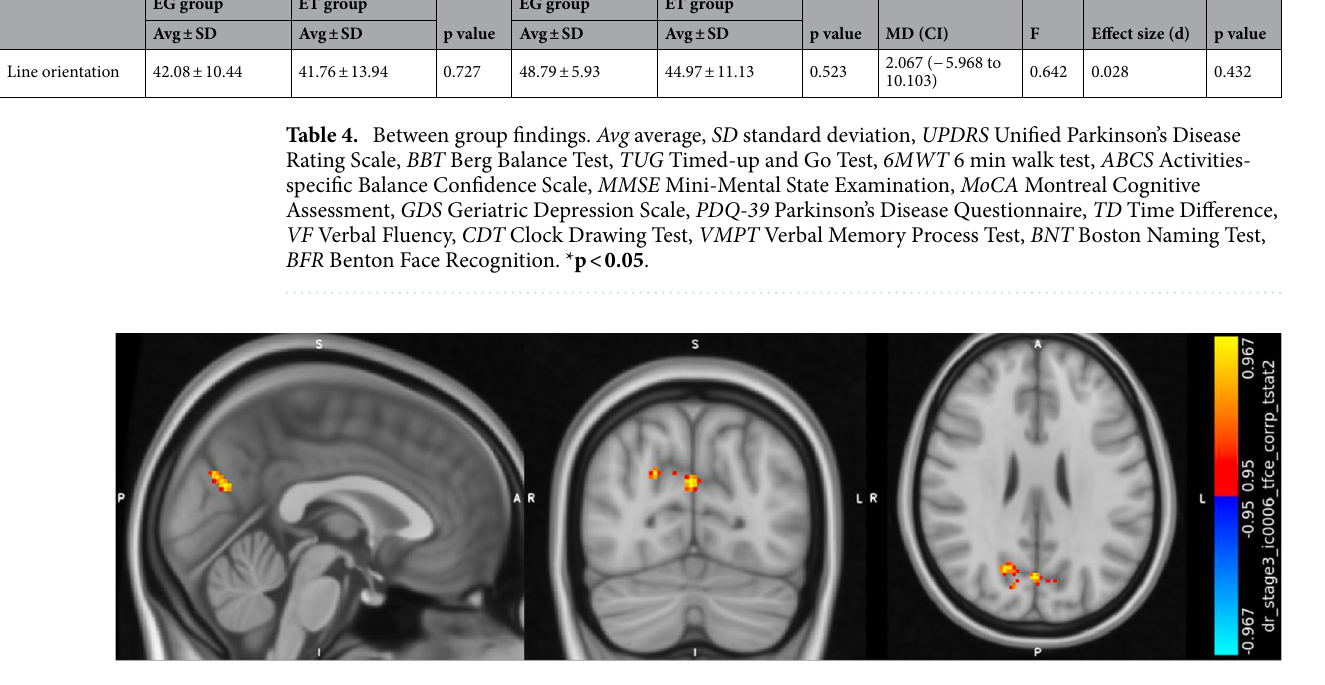
Figure 2. Results of rs-fMRI analysis in the between group comparison. Between groups comparisons, results of Dual Regression with group × time interaction, showing increased activation in the precuneus cortex (Harvard-Oxford Atlas), corrected for multiple comparisons with threshold-free cluster enhancement (tfce, p-value < 0.05). Peak MNI152 coordinate: [0 −72 25]; Number of voxels in the significant cluster: 154; Minimum p-value: 0.0326; t-value: